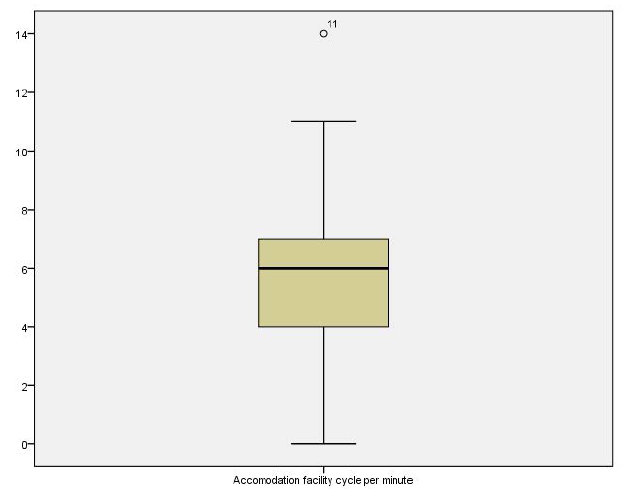
Figure 1 Distribution of accommodation facility